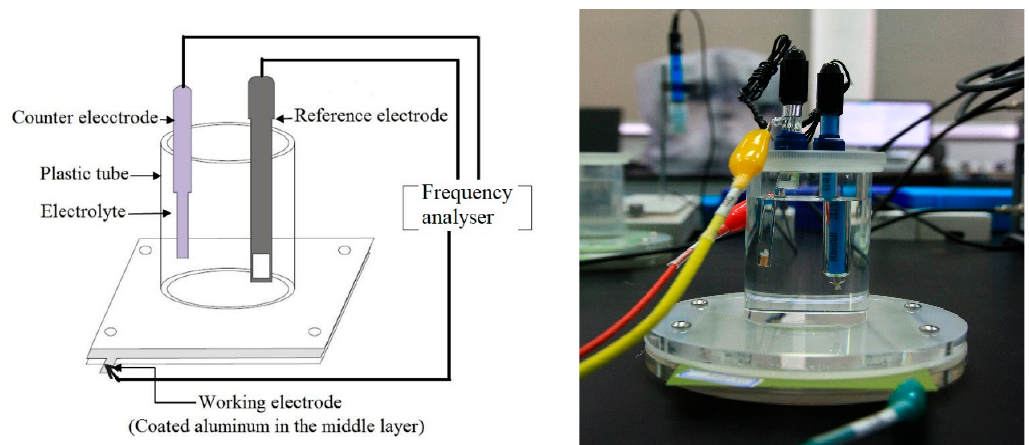
Figure 2. Three-electrode system used for the immersion test and EIS measurements on the coated Al-alloy.